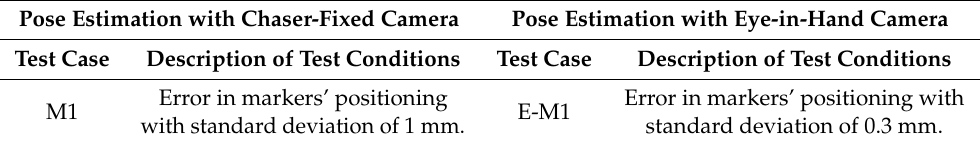
Table 10. Summary of test cases with errors in the positioning of the markers on the target for both the pose estimation with the chaser-fixed and the eye-in-hand